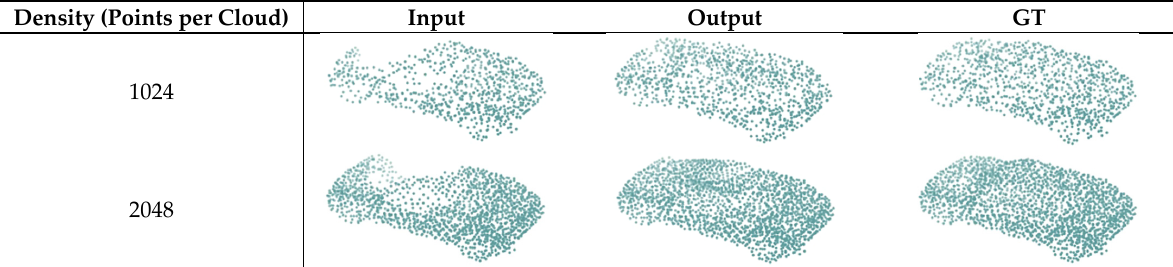
Figure 7. The completion shape of different densities.